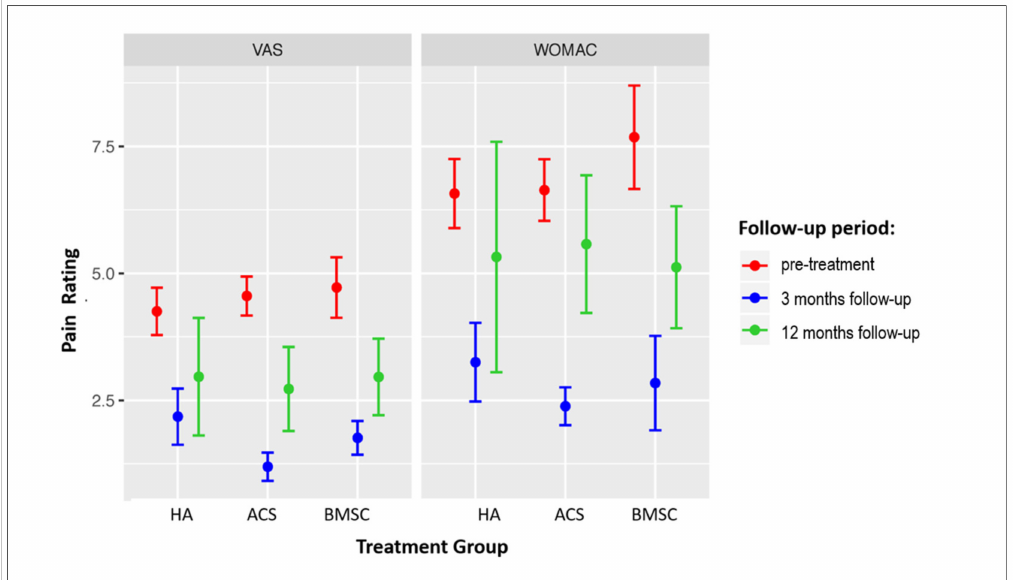
Figure 2. Forest plot showing VAS and WOMAC scores in patients treated with three different treatment modalities. Mean score values ± SEM are presented. Sample sizes of individual groups are presented in Figure 1. OA = osteoarthritis; VAS = Visual Analogue Scale; WOMAC = Western Ontario and McMaster Universities Osteoarthritis Index. HA = hyaluronic acid; ACS = autologous conditioned serum; BMAC = bone marrow aspirate concentrate. Table 4. Change in VAS score 3 and 12 months after the treatment with HA, ACS and BMAC. Pretreatment 3-Month Follow-Up 1-Year Follow-Up Treatment